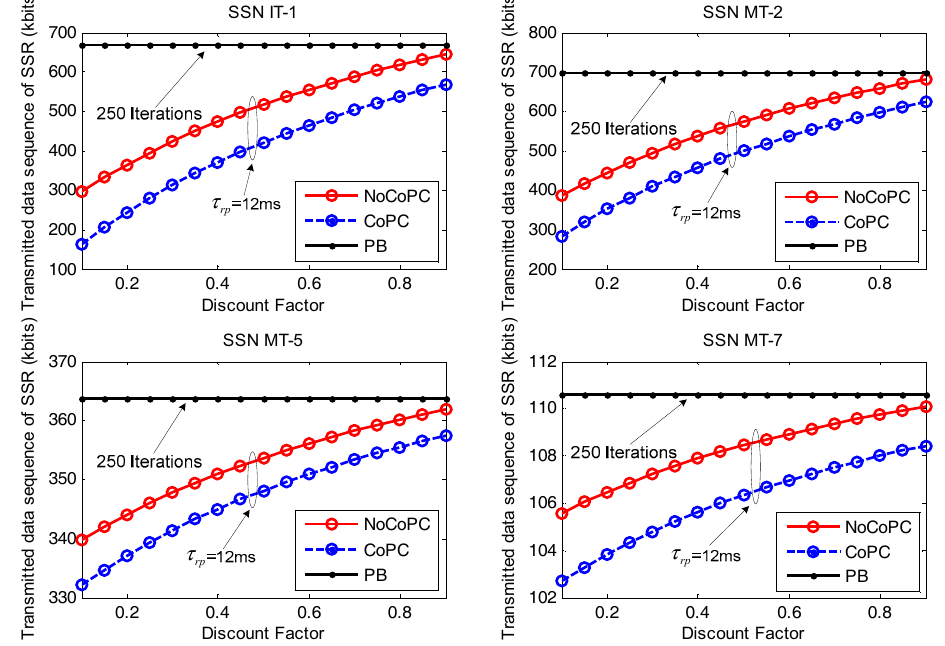
Figure 10. Transmitted data sequence of SSR vs. discount factor r ( τ rp = 12 ms, l = 250 iterations).